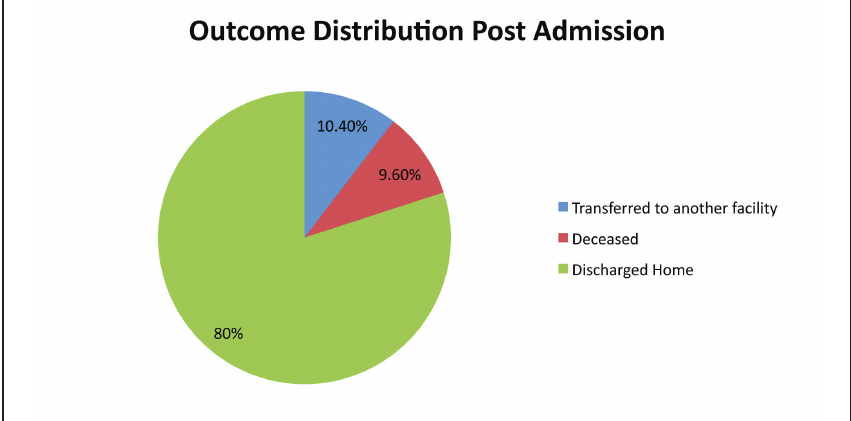
Figure 1: Outcome distribution post admission